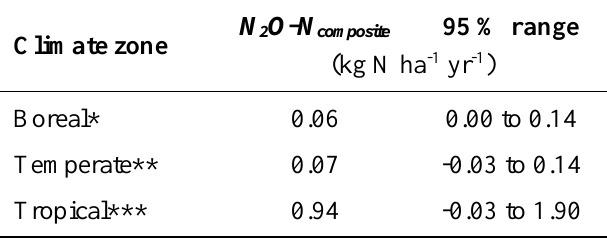
4. Emission factors for nitrous oxide ( N 2 O-N composite ; kg N ha -1 yr -1 ) in rewetted organic soils and associated uncertainty range confidence intervals).